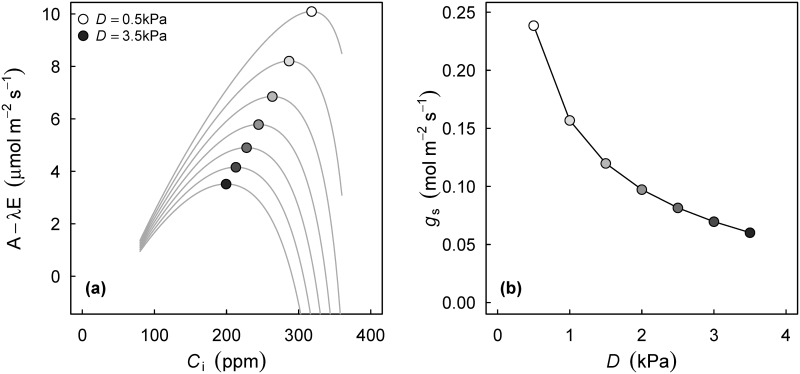
Visualization of the optimal model of stomatal conductance.Provided we have an estimate of the 'cost of water' (λ, mol C mol H2O-1), stomata act to maximize photosynthesis minus transpiration. In (A), individual curves at a range of values for the vapour pressure deficit (D) are plots of A−λE as a function of Ci, demonstrating that an optimum Ci exists. The FARAO function finds this optimum numerically and calculates corresponding An and gs. The corresponding response of gs to D is shown in panel (B).